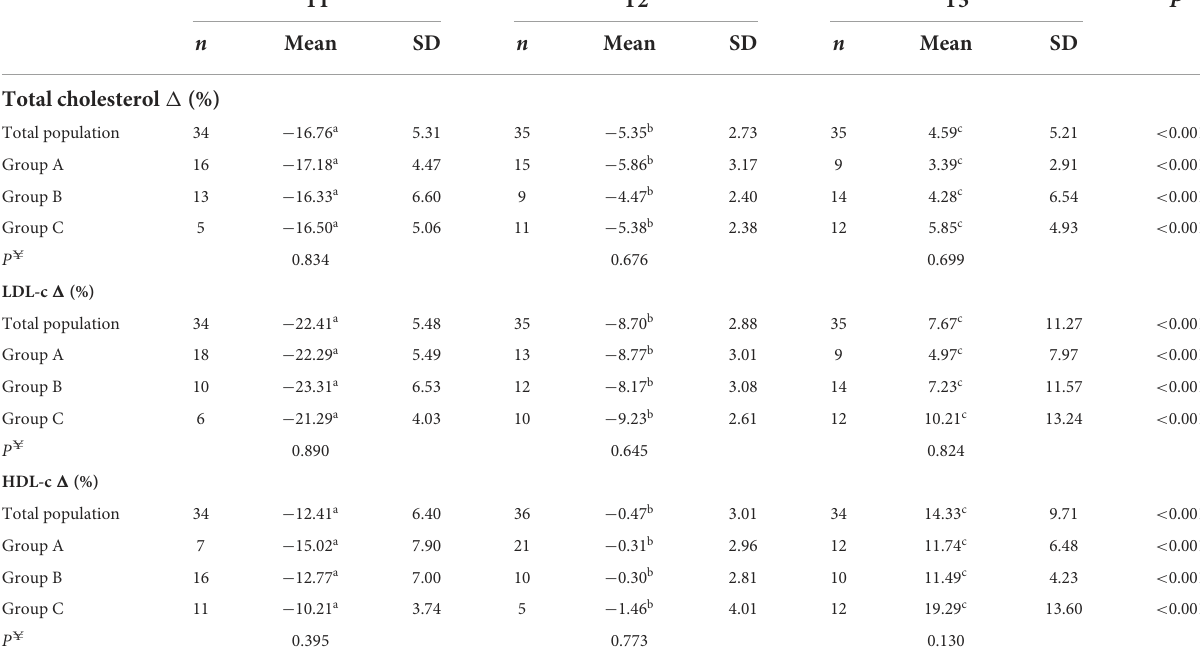
TABLE 2 Percentage change in TC, LDL-c, and HDL-c across tertiles of percentage change at total population level, compared across intervention groups A–C. T1 T2 T3 P *